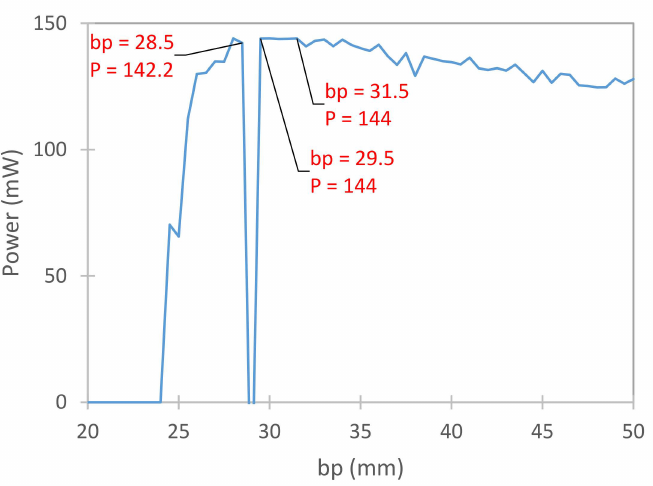
Figure 10. Graph Showing Variation of Power Output with Piezoelectric Layer Width b p .